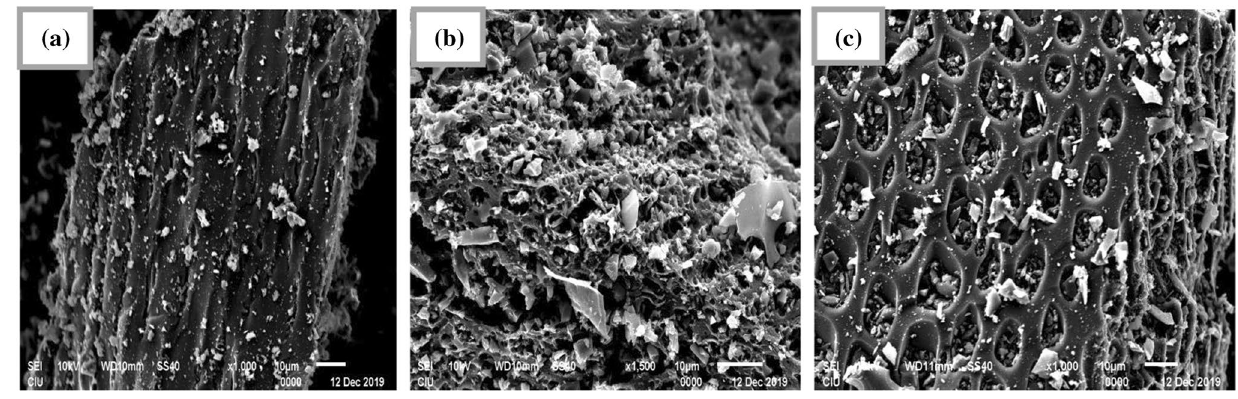
Fig. 1 SEM images of a AWS (before KOH activation), b KOHAWS1 after activation, and c KOHAWS2 after